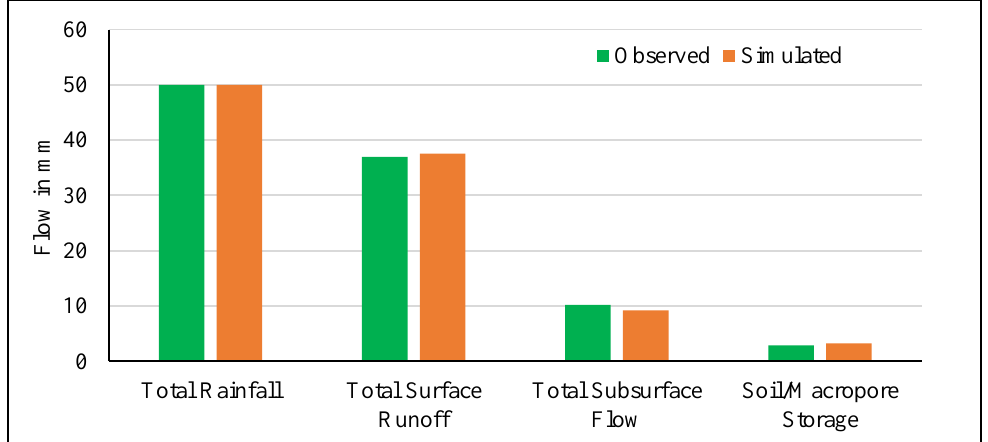
Figure 14. Water balance for rainfall intensity of 100 mm/h for 30 min.